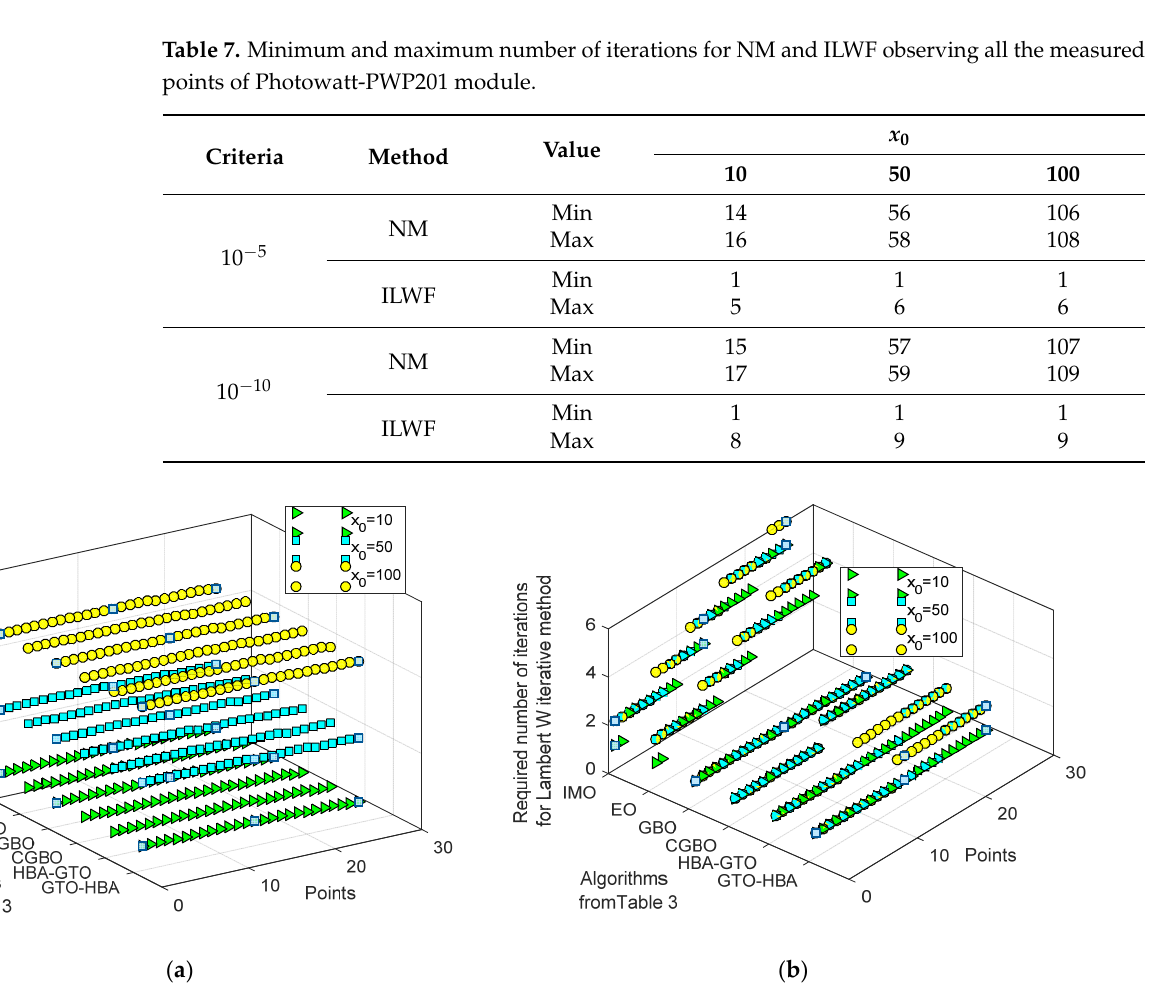
Figure 13. Required number of iterations for all voltage values for a stopping criterion set to 10 − 5 using: ( a ) NM; ( b ) ILWF.